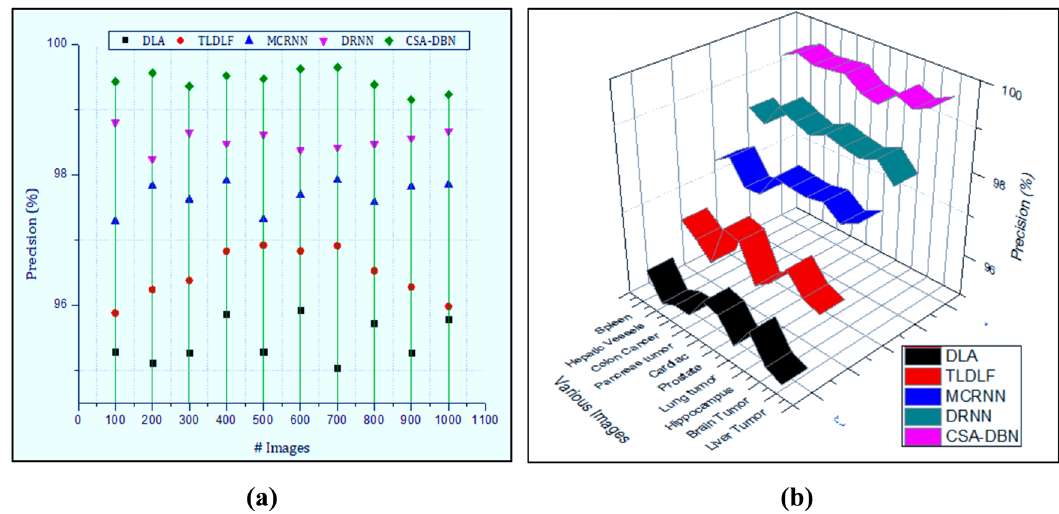
Figure 6: Precision analysis: ( a ) # images and ( b ) di ff erent images.